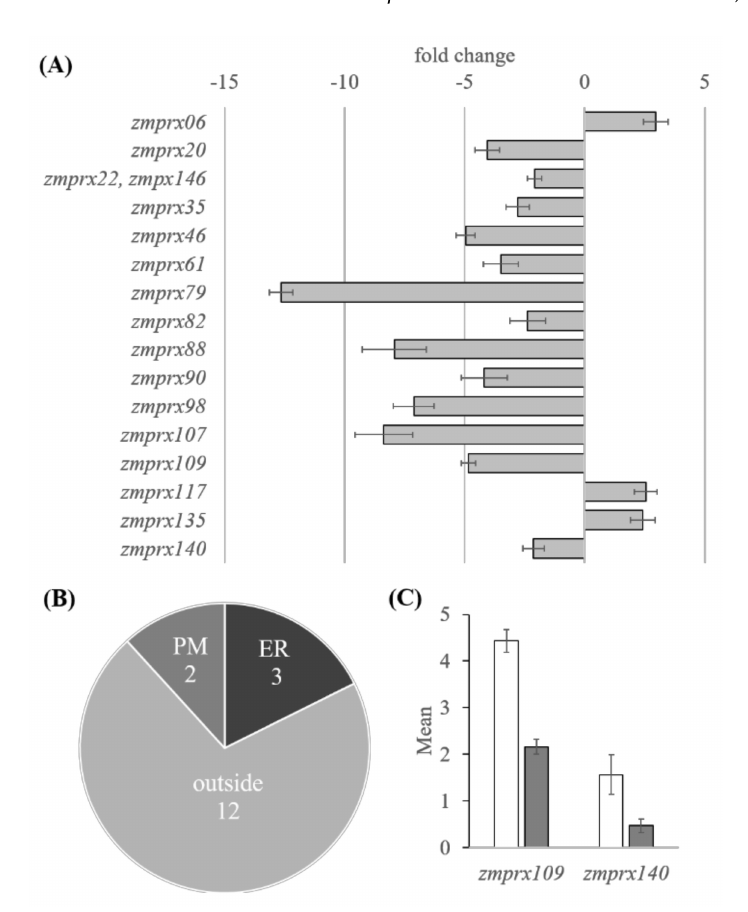
Figure 1. Di ff erential regulation and putative localization of class III peroxidases under hypoxia. From three non-stressed and 24 h hypoxia-stressed root samples, expression profiles were calculated as Fragments Per Kilobase Million (FPKMs). Di ff erentially expressed gene (DEG) results were performed on a comparison pair (stressed versus controls), using FPKM with a fold change > 2 and Student’s t -test p < 0.05. ( A ) Di ff erential expressed peroxidases (excluding pseudogenes) with their fold change expression and ( B ) their predicted localization, using PSORT (http: // psort1.hgc.jp / form.html) at either the plasma membrane (PM), the endoplasmic reticulum (ER) or “outside” (apoplast, cell wall). ( C ) Gene expression (mean = mean of normalized signal for each sample or group) of the two putative plasma membrane-bound class III peroxidases that were di ff erentially expressed in controls (white columns) and hypoxia-stressed samples (gray columns). Error bars indicate standard deviation (three biological